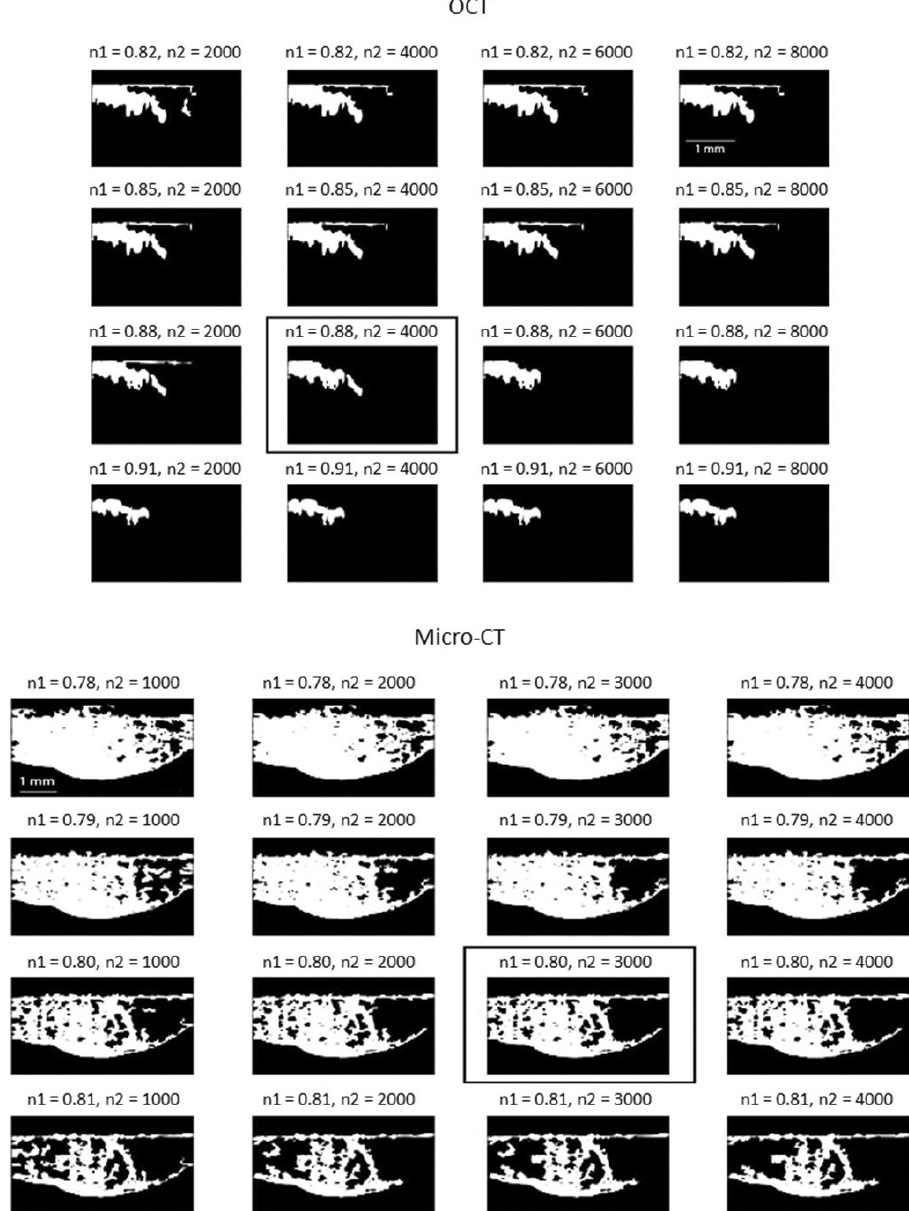
Fig. 4. Optimization of texture-based ¯ltering. In both sets of OCT and micro-CT images, the tumor tissue is located on the left. The columns show increasing correlation distance ( n 2) from left-to-right and the rows show increasing kernel size ( n 1) from top-to- bottom. The optimum con¯gurations are selected visually